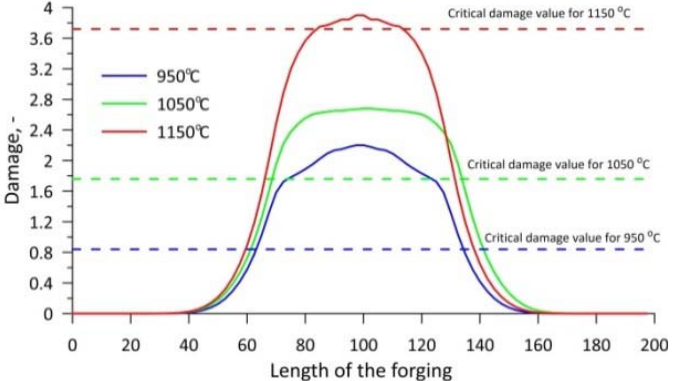
Figure 6. Distribution of damage values along the axis of the forgings and critical damage values.